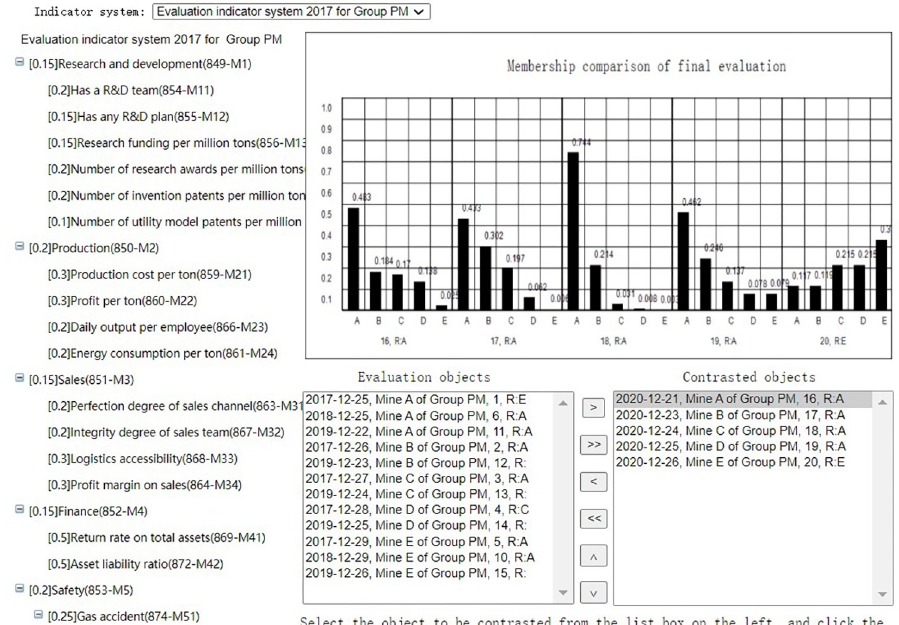
Fig 20. Horizontal membership